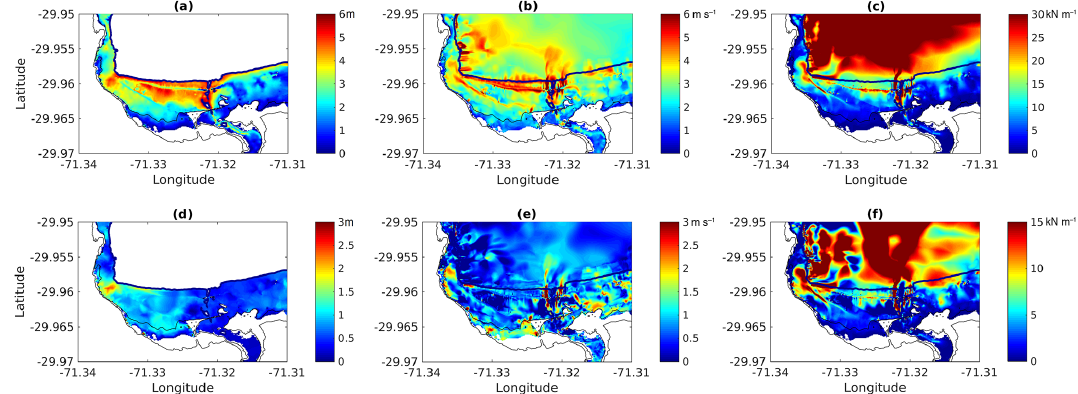
Figure 12. Results of tsunami numerical simulation of the S1 event ( M w = 8 . 2). (a) Inundation depth, (b) flow velocity, (c) hydrodynamic force and (d) increase in inundation height compared to the 2015 Coquimbo tsunami. (e) Increase in flow velocity compared to the 2015 Co- quimbo tsunami. (f) Increase in hydrodynamic force compared to the 2015 Coquimbo